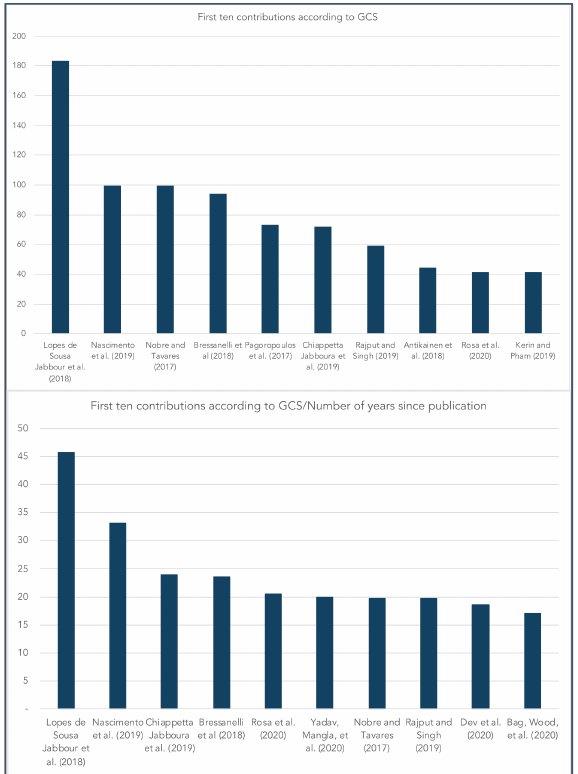
Figure 7. First ten contributions according to GCS and GCS/number of years after